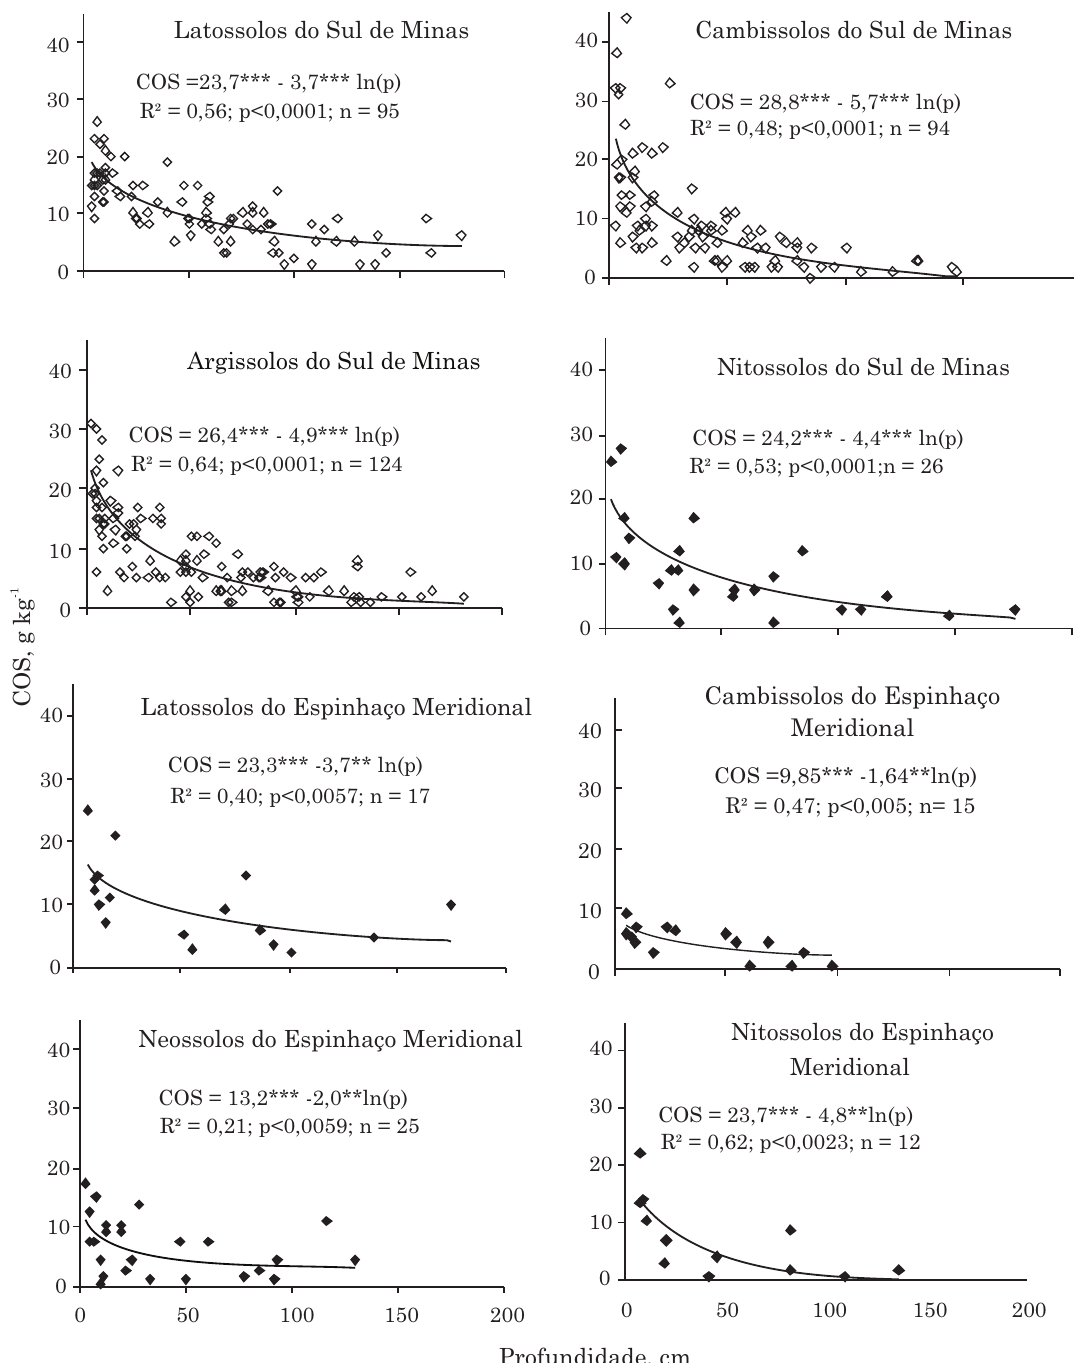
Figura 3. Perfis de carbono orgânico do solo (COS) para as principais classes de solos das regiões Sul e Serra do Espinhaço Meridional, MG. O nível de significância para os parâmetros intercepto e fator logarítmico é representado por *,** e ***, respectivamente, para p<0,05, p<0,01 e p<0,001.